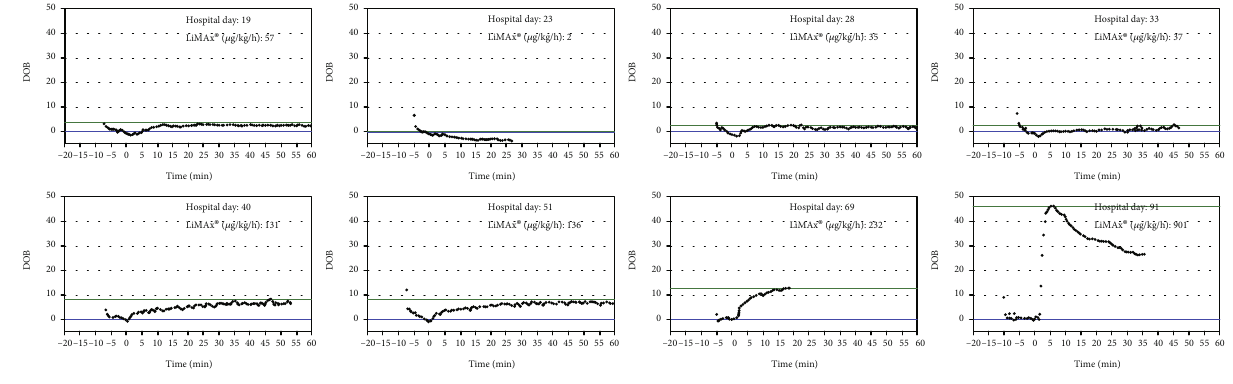
Figure 3: LiMAX® measurement